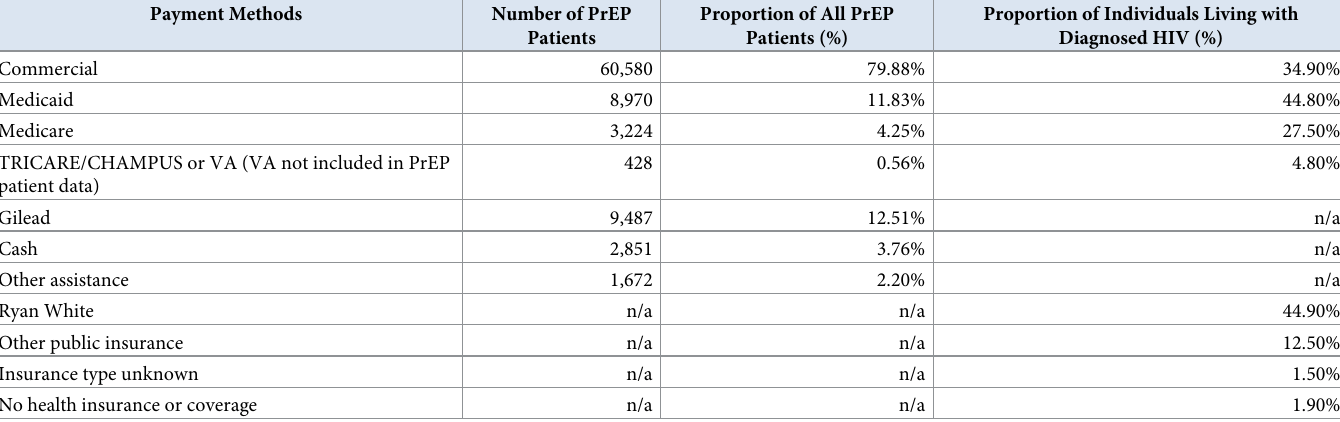
Table 3. Payment methods of PrEP patients, September 2015 through August 2016, and type of health insurance of coverage for antiretroviral medications for PLWH. Payment